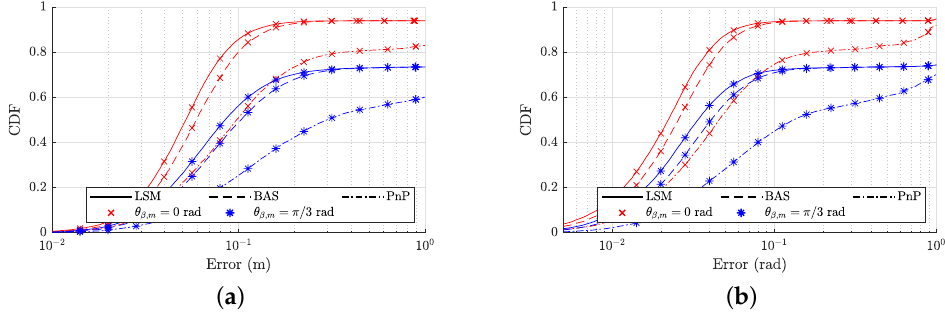
Figure 10. CDF of RMSE for position and orientation estimates for z d = 2 m: ( a ) position error; ( b ) orientation error.